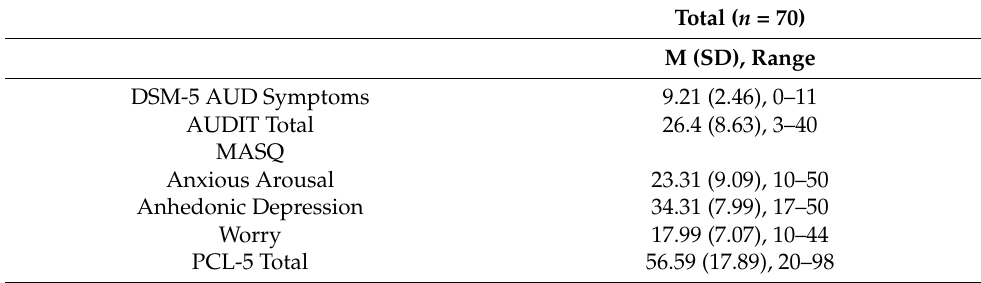
Table 2. DSM-5 symptoms, AUDIT, MASQ, and PCL-5 scores.